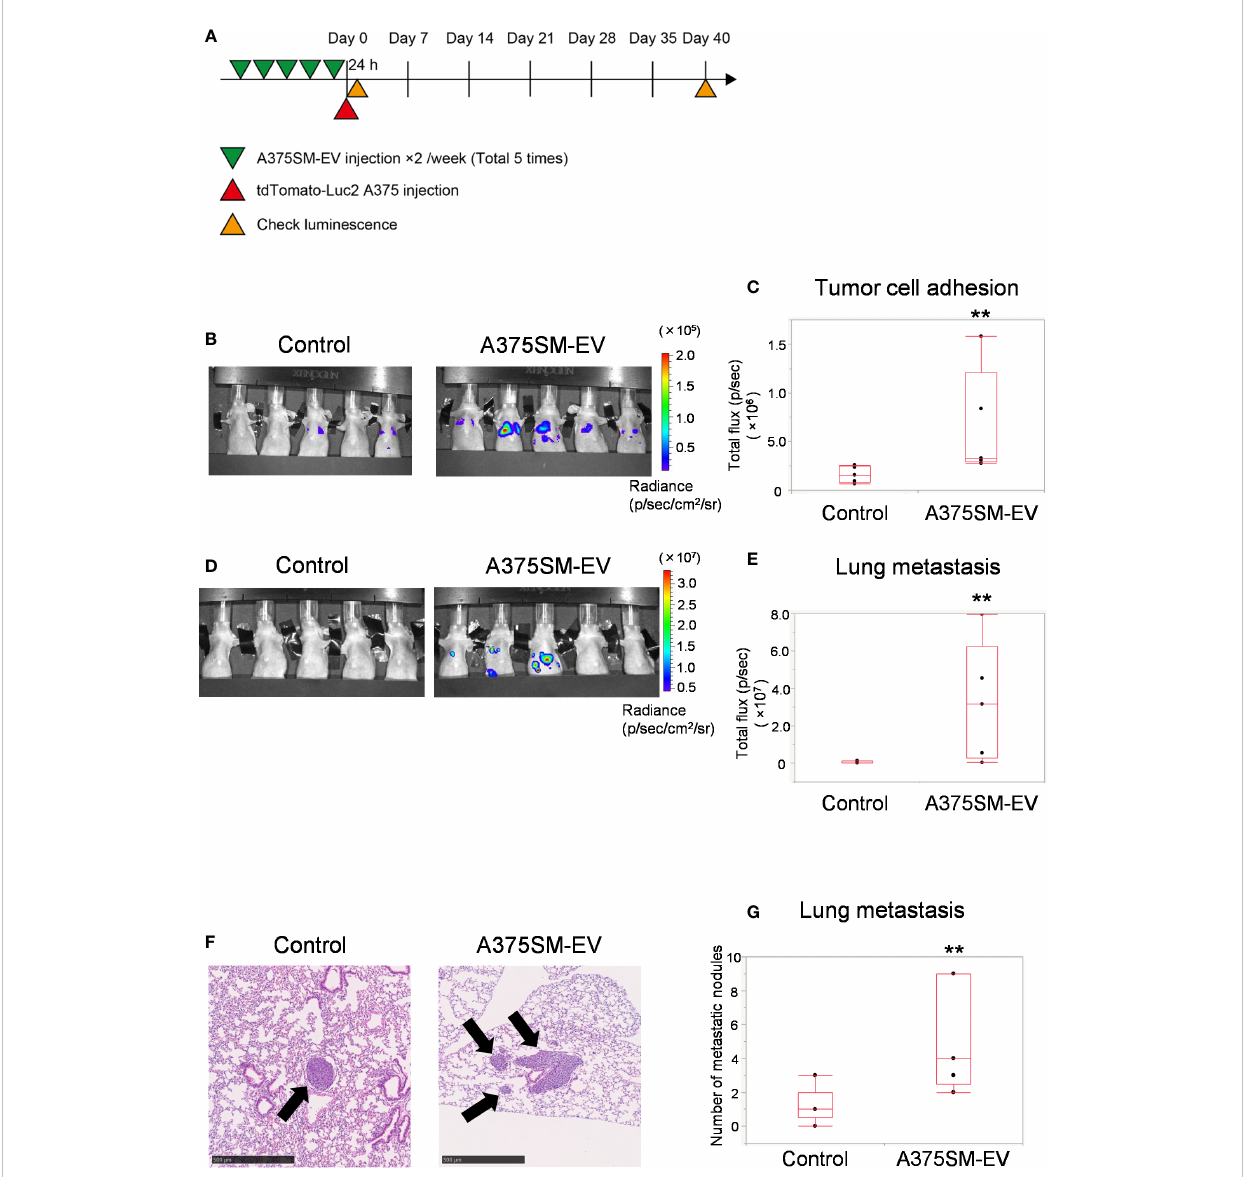
FIGURE 1 High metastatic tumor EVs induce tumor cell adhesion to the lung and promote lung metastasis. (A) The experimental design of tumor EV and tumor cell injection. Tumor cells were injected after fi ve injections of A375SM-EVs. After 24 h and 40 days, tumor cell signals were analyzed using an in vivo imaging system (IVIS). (B, C) Tumor cell luminescence intensity in the lungs of the control and A375SM-EV injected groups was detected using IVIS Spectrum 24 h after tumor injection (B) . Quantitative analysis of luminescence intensity (Total fl ux) was shown in (C) (**P = 0.012, Wilcoxon test; n = 5 mice per group). (D) Tumor cell luminescence intensity in the control and A375SM-EV injected groups after 40 days from tumor injection was detected using IVIS Spectrum. Quantitative analysis of luminescence intensity (Total fl ux) was shown in (E) (**P = 0.037, Wilcoxon test; n = 5 mice per group). (F) Representative H-E staining images of lung metastases in the two groups. Arrows indicate tumor nodules. (G) The number of metastatic nodules in the whole lung tissue was quanti fi ed (**P = 0.026, Wilcoxon test; n = 5 mice per